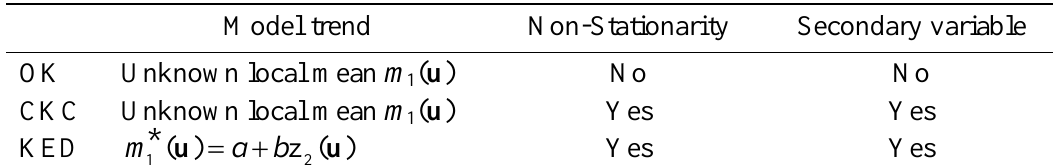
Table 1. Summary table of the geostatistics